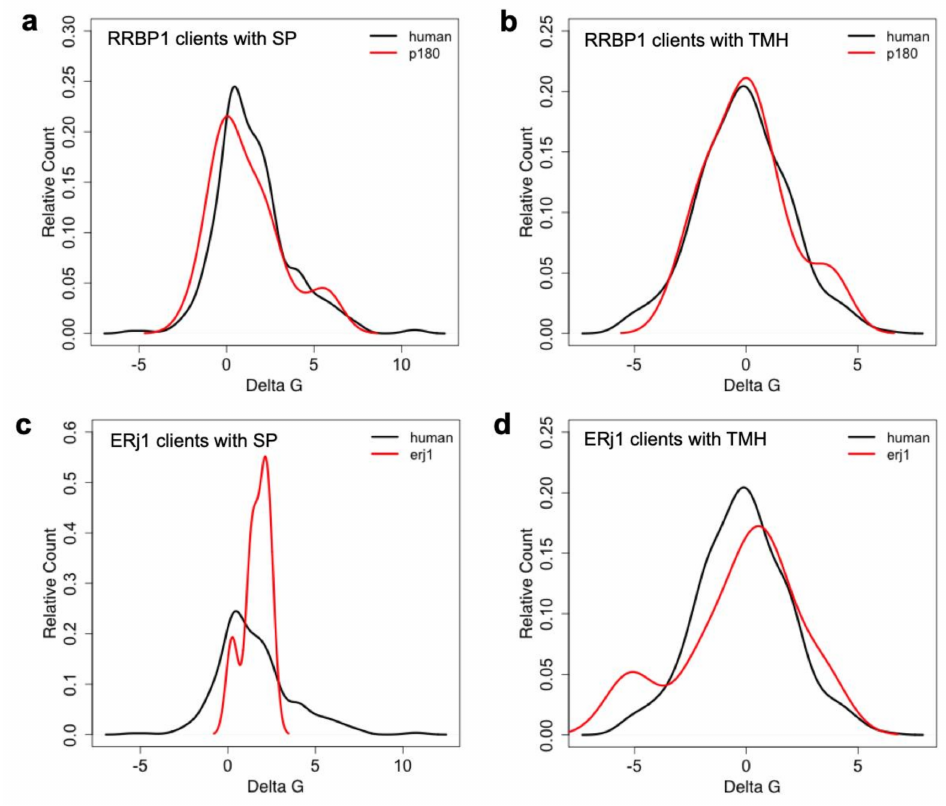
Figure 12. Physico-chemical properties of TRAP clients with SP or TMH. delta G app values of SPs ( a , c ) and TMHs ( b , d ) were determined for RRBP1 (p180) and ER1 (erj1) clients with the delta G app predictor for TM helix insertion (https: //dgpred.cbr.su.se/index.php?p=home, (accessed on 2 May 2021)) and plotted against the relative count in comparison to all human SPs and